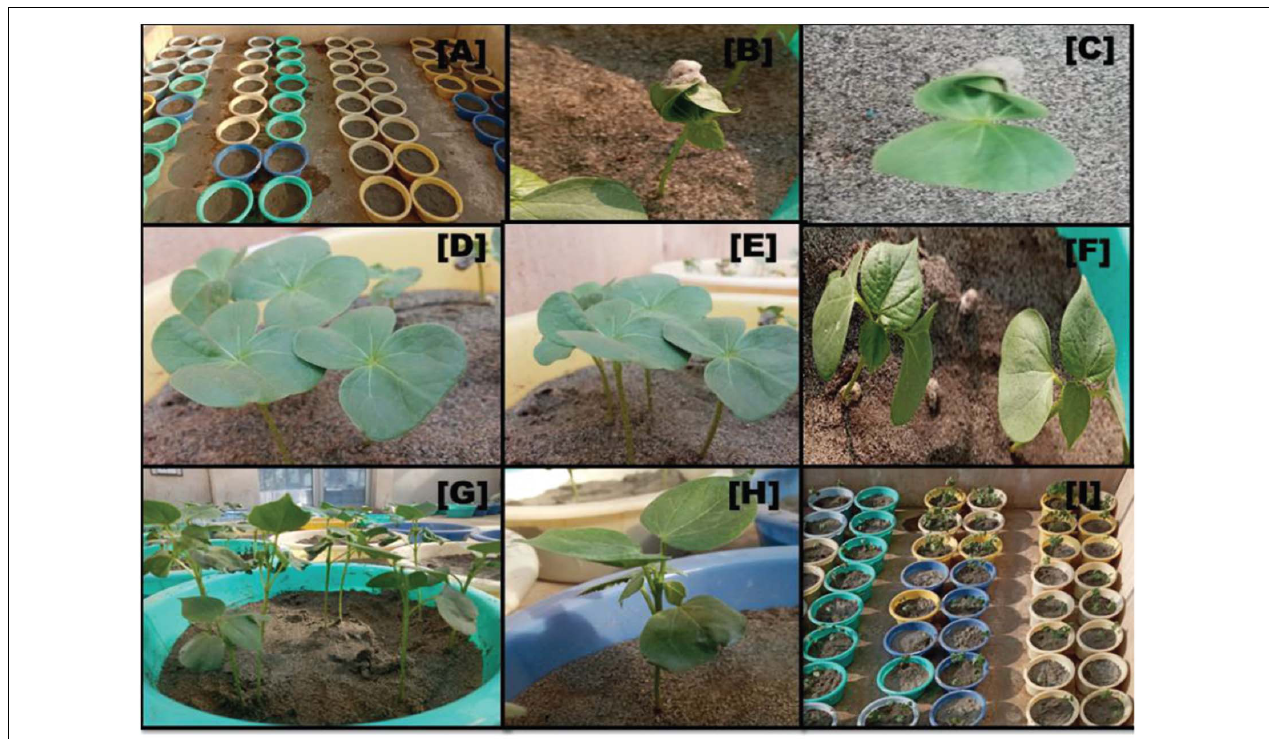
FIGURE 1 | Visual appearance of seedling emergence under glass house conditions: (A) sowing of seeds in sand pots; (B,C) epicotyl emergence of cotyledon leaf 4 DAT sowing; (D,E) full emergence of cotyledon leaves; (F) first and second true leaves emergence; (G,H) seedlings at fourth true leave stage; and (I) the overall view of sand pots before the day of